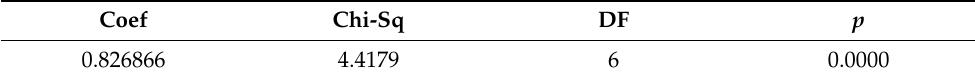
Table 2. Summary results of the Delphi method to determine and weigh the selection criteria. Level of Weighting (Ci) Criteria Description Agreement (Cc) Level of complexity to interpret Understandability 0.93 0.172 the component’s visual output. Processing speed of data Quickness 0.80 0.079 samples. Level of coverage of the